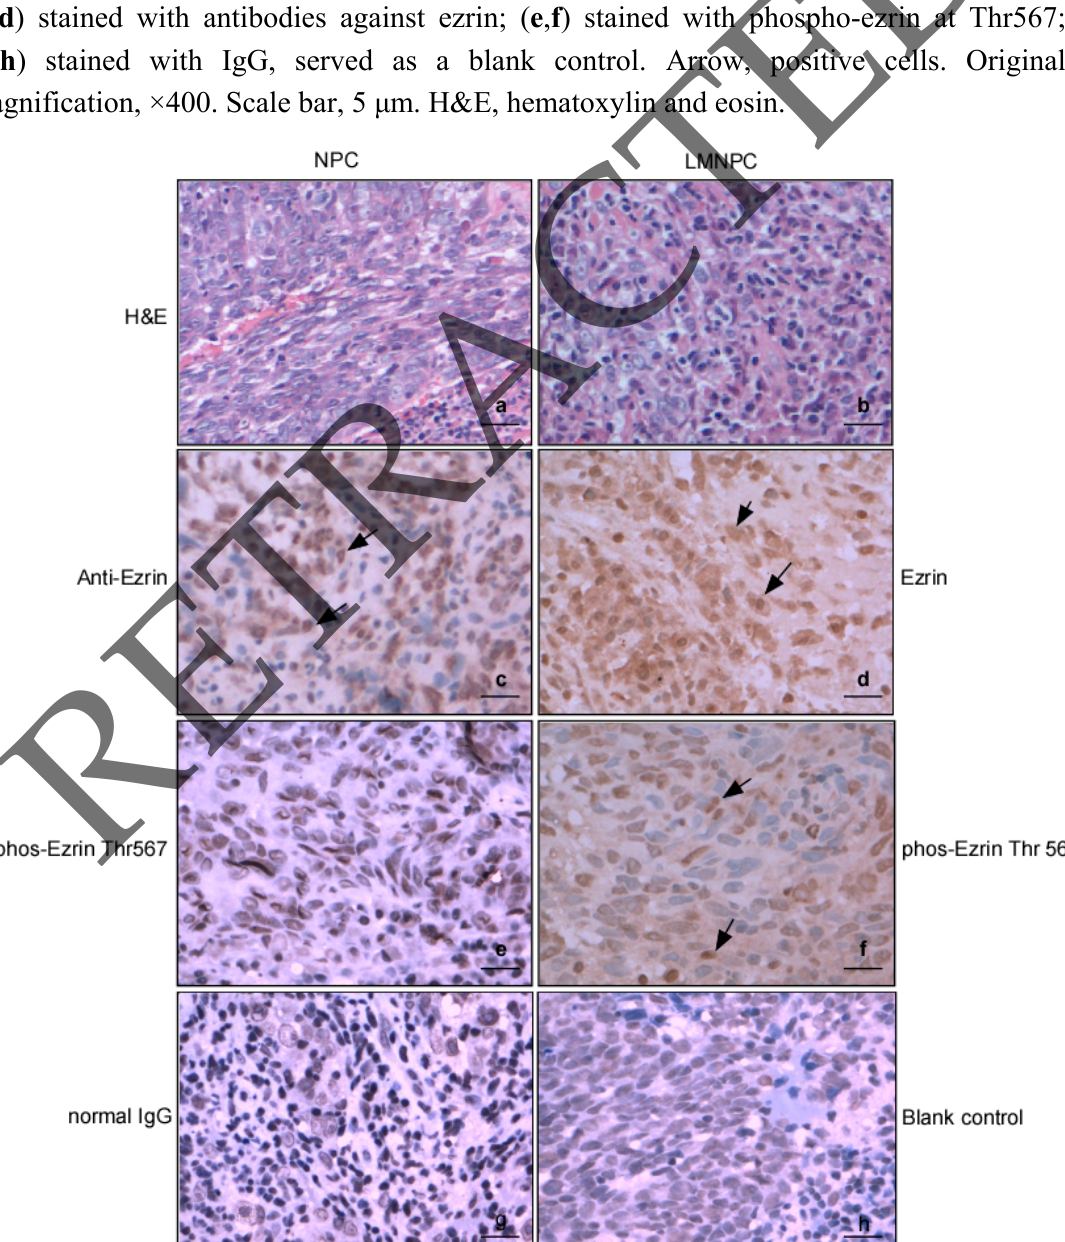
Figure 6. Phospho-ezrin and ezrin expression in NPC metastatic nodes. Phospho-ezrin